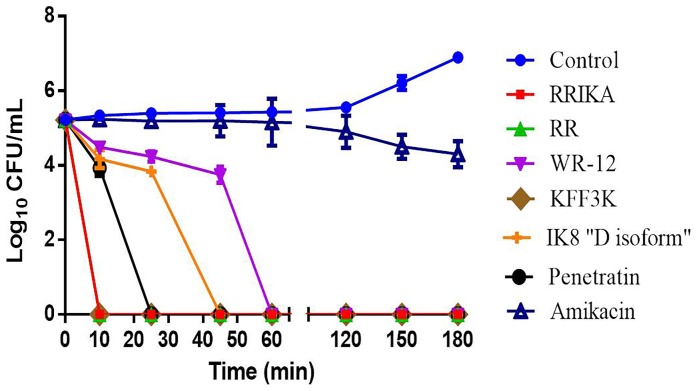
Bacterial killing kinetics of peptides (RRIKA, RR, WR-12, (KFF)3K, IK8 “D isoform” and penetratin) and antibiotics amikacin at 5X MIC against SP 3 in MHB (Mueller Hinton broth).Samples treated with peptide diluent (sterile water plus 0.2% acetic acid) were used as a control. The killing curves were identical (overlapping in the figure) for RRIKA, RR and (KFF)3K. The results are given as means ± SD (n = 3; data without error bars indicate that the SD is too small to be seen).